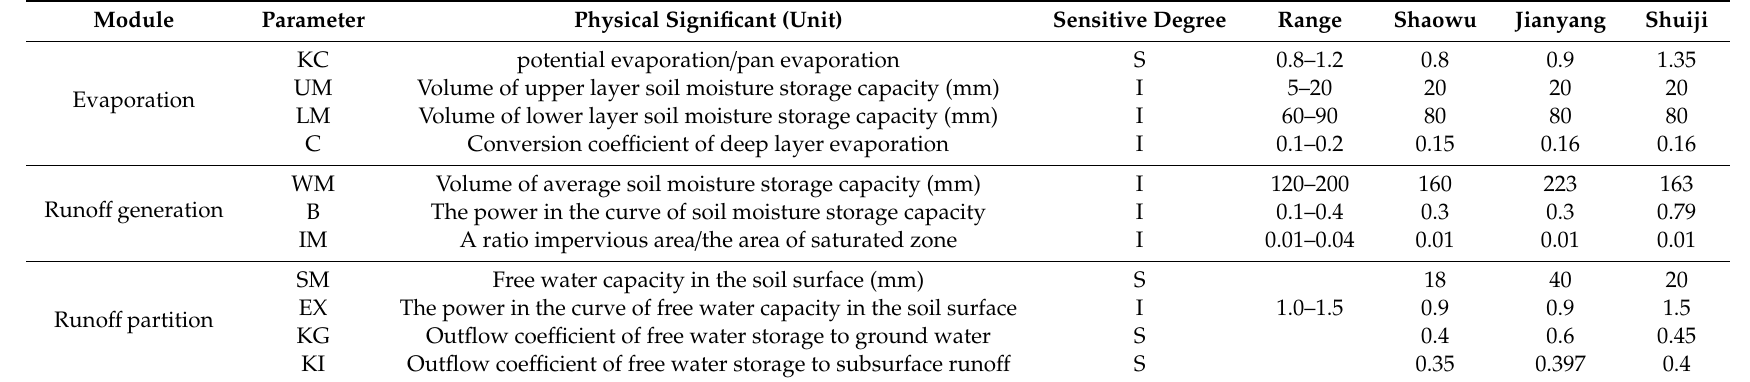
Table 2. Parameter of the XAJ model (in the sensitive degree column, S stands for sensitive and I for insensitive; the range of every parameter is for reference, and the corresponding values of Shaowu, Jianyang, Shuiji catchments are presented in the list are all under calibration).